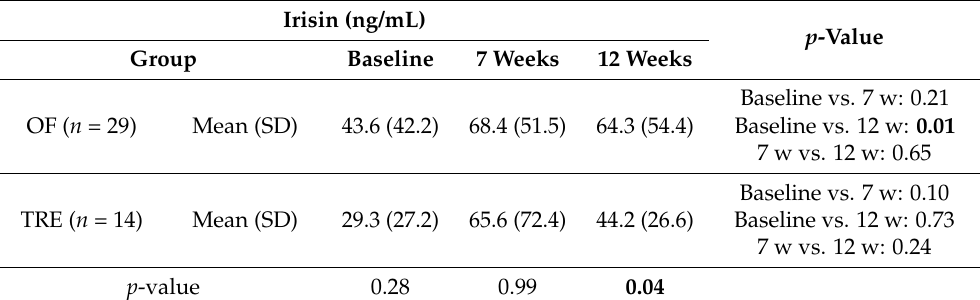
Table 2. Evolution of irisin concentrations throughout the study period in the two groups.